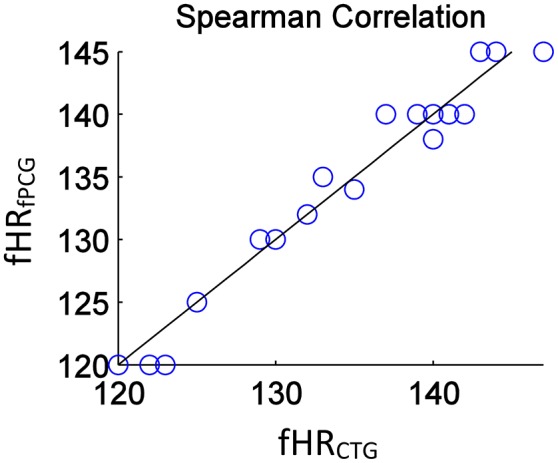
The estimated Spearman correlation coefficient of ρ = 0.95 (significance p < 0.001) yields a linear regression between fHRfPCG (bpm) and fHRCTG (bpm).